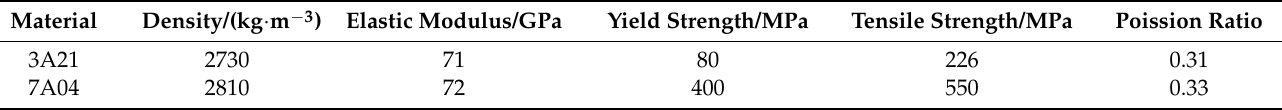
Table 2. Chemical compositions of the aluminum alloys (wt %).